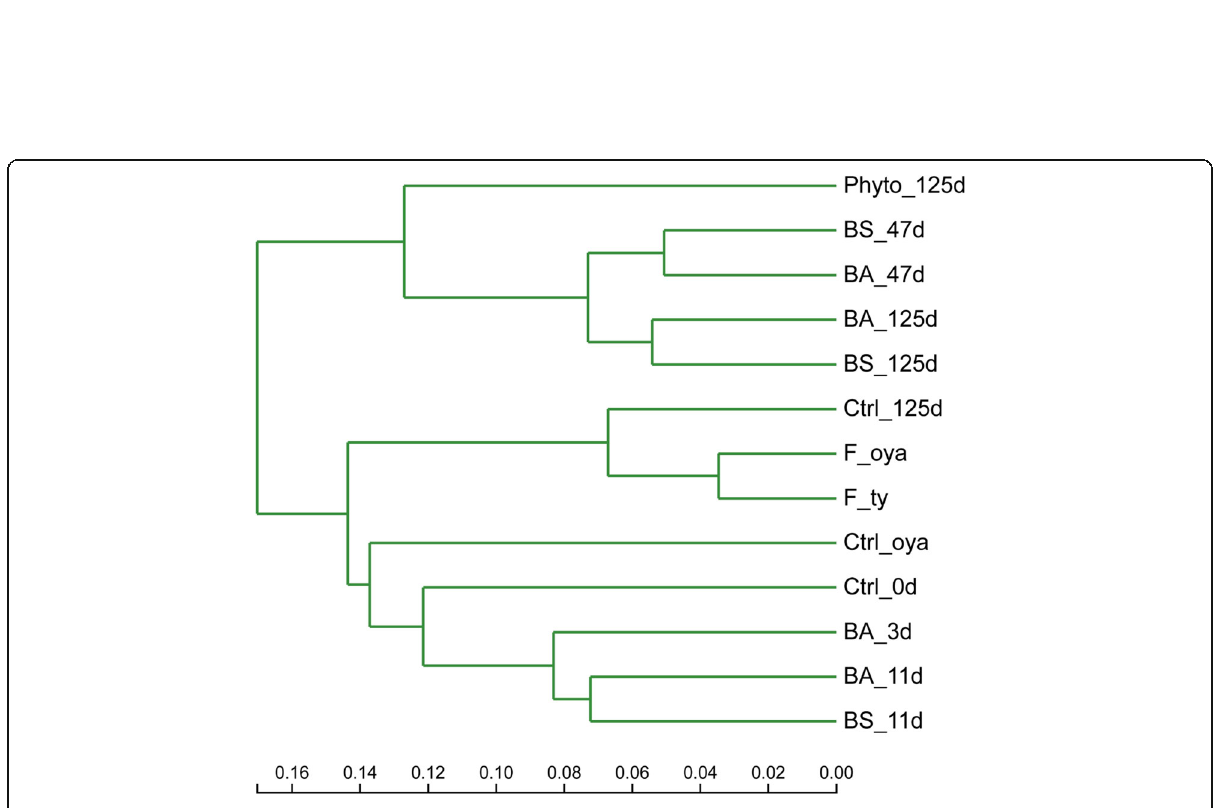
Fig. 6 Cluster analysis of the samples based on the weighted UniFrac distance and 16S rRNA